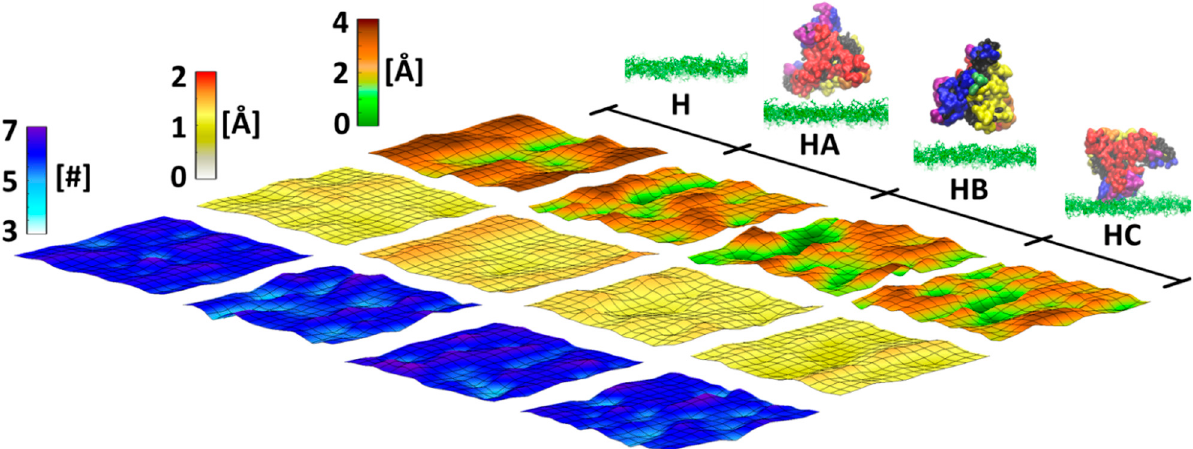
Figure 5. The averaged topology heights of the polymer chains (top), the RMSF of the polymer chains (middle), and the water hydration of the polymer chains (bottom) i.e., number of water molecules around the polymer chains, at high-density surface in the absence of the foulant (model H, left), and in the presence of the BSA foulant at three orientations: models HA, HB, and HC (see Figure 2 for details about the different models). The final simulated snapshots are illustrated for each model.